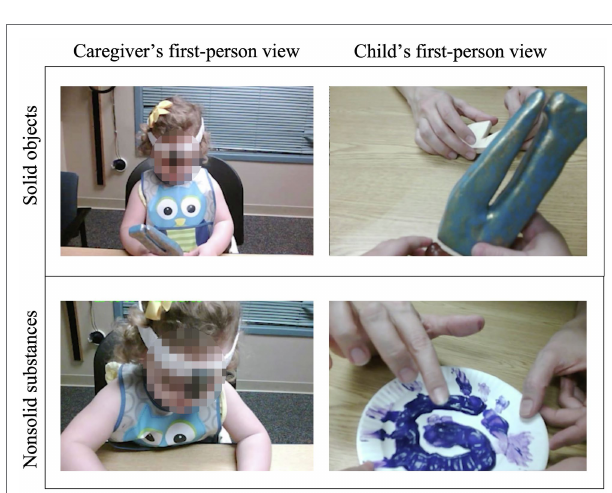
FIGURE 2 | Example first-person views from a caregiver’s (left) and child’s (right) perspectives of free-play with solid objects (top) and nonsolid substances